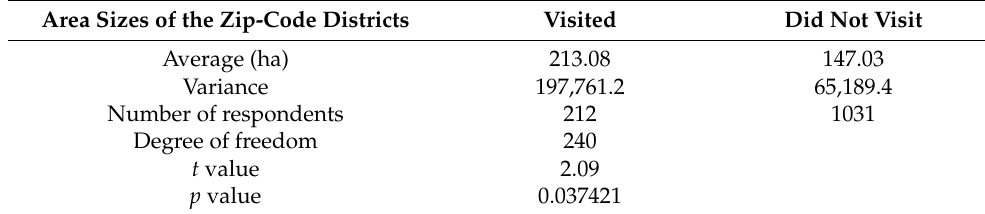
Table 2. Area sizes of the zip-code districts of respondents who visited/did not visit mountains in the emergency